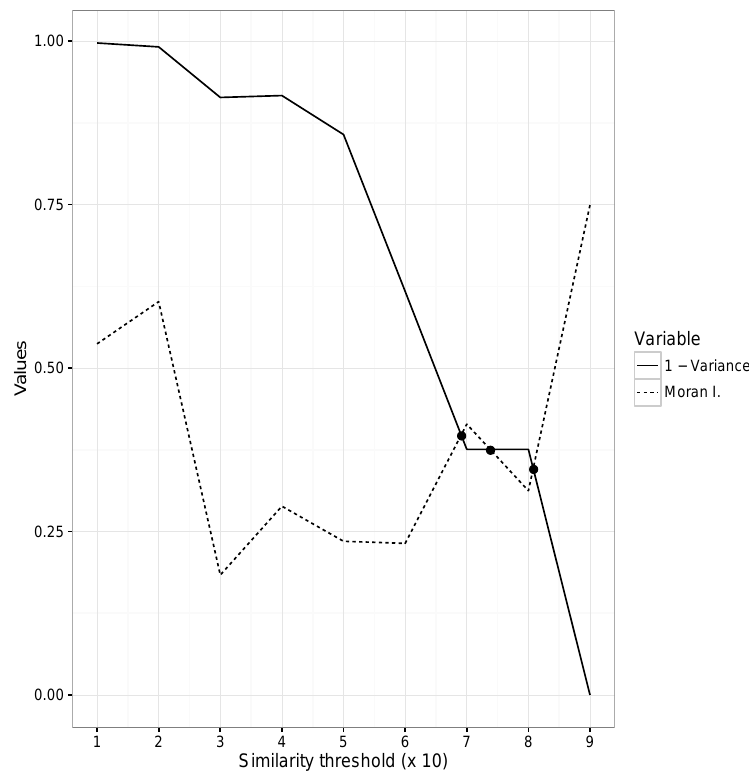
Figure 9. Example of autocorrelation and variance curves used for the optimization of the similarity threshold parameter for Canaima National Park. Variance refers to the mean internal variance of all of the segments based on all input variables, and Moran’s I refers to the mean autocorrelation based on all input variables. See Section 2.3 for more